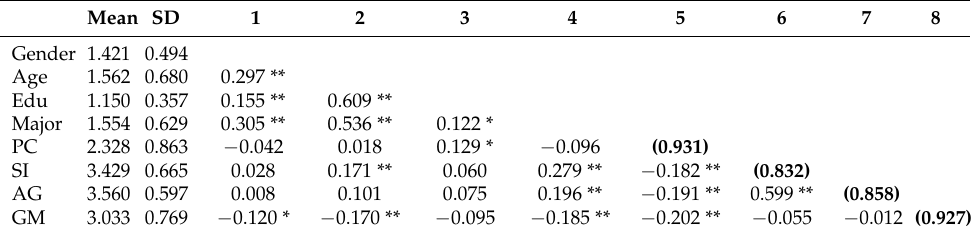
Table 3. Mean, standard deviation and correlation statistics ( N = 354).